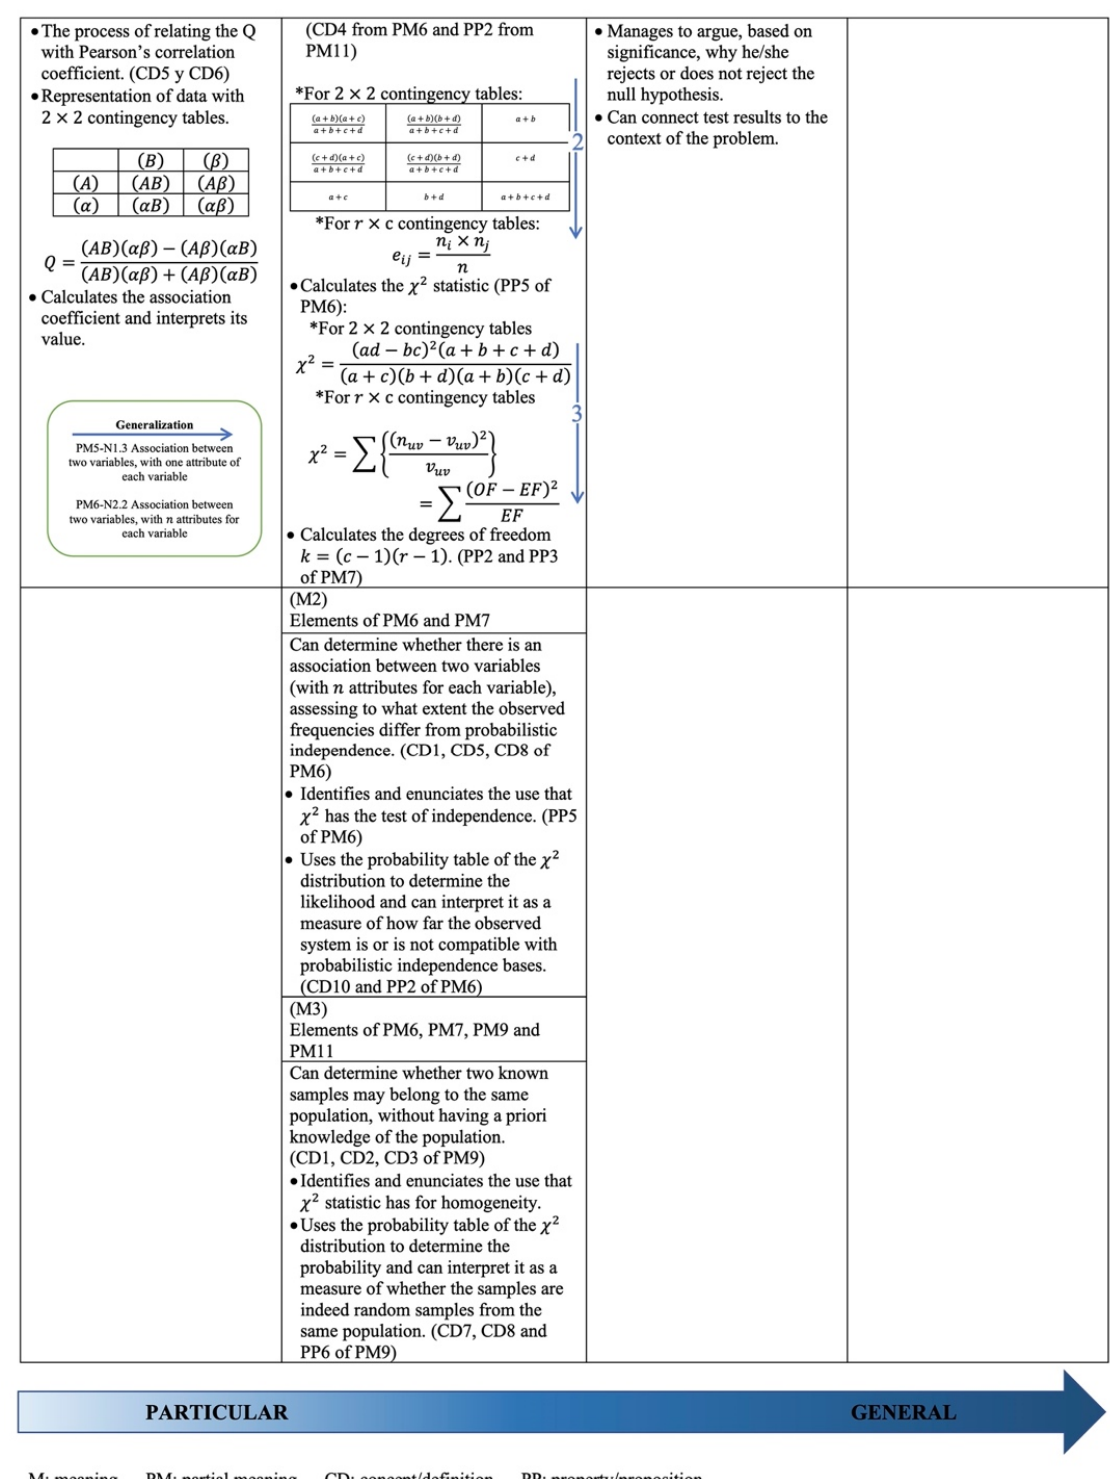
Figure A2. Levels of inferential reasoning on the Chi-square statistic (Part 2).